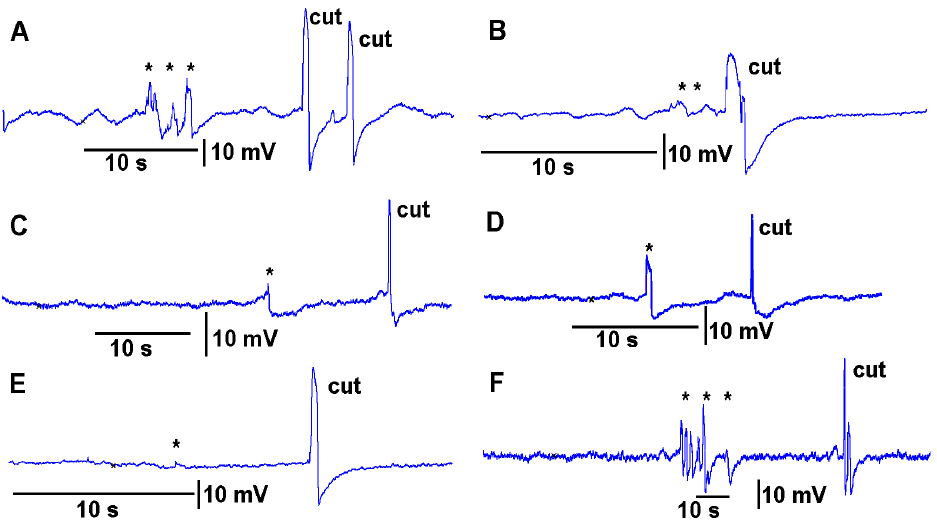
Figure 7. The effect of bending a leaf and cutting the same leaf while measuring the impedance changes by recording with both leads placed within the stem of tomato plants. ( A – F ) illustrates six different plants. The asterisk (*) shown in each recording demarcates a bending of the leaf as a test for the effect of movement on the leaf which occurs while cutting a